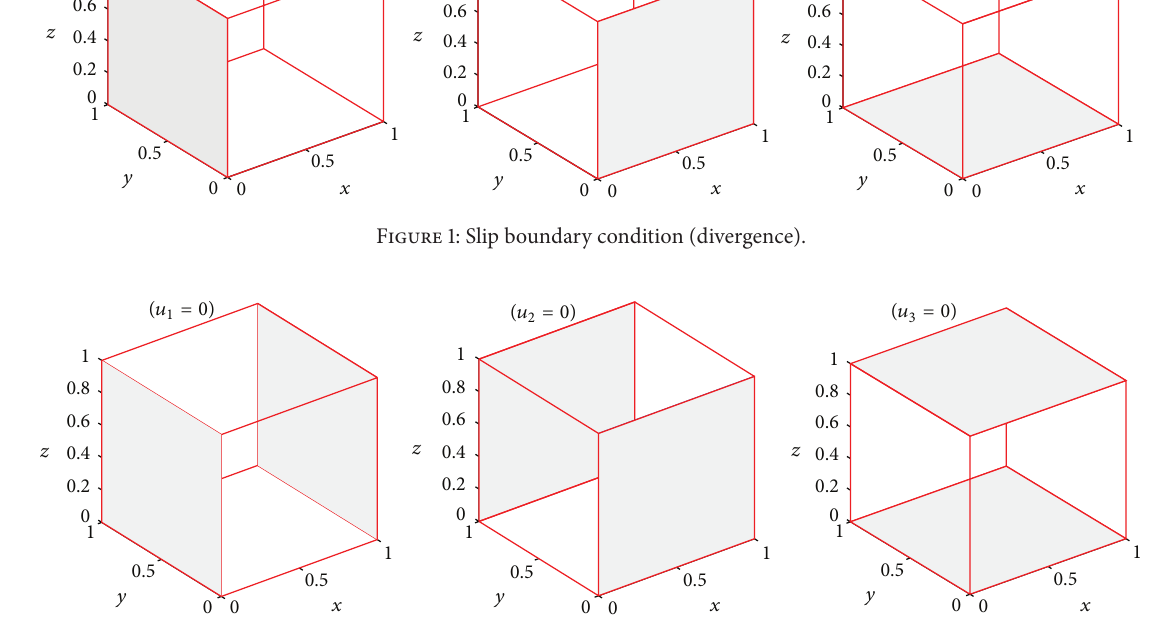
Figure 2: Free-slip boundary condition